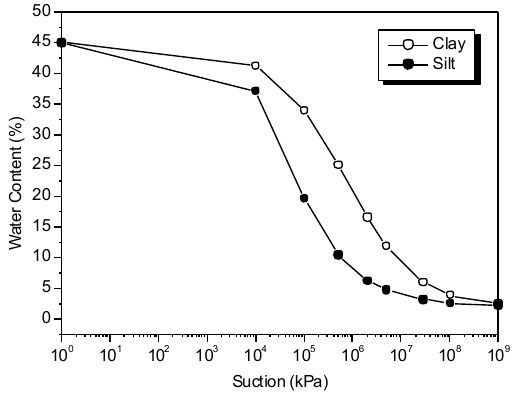
Figure 12a. Hydraulic conductivity of the clay and silt considred in the parametric study. Figure 11a. Influence of the protection area on the varition of the soil suction